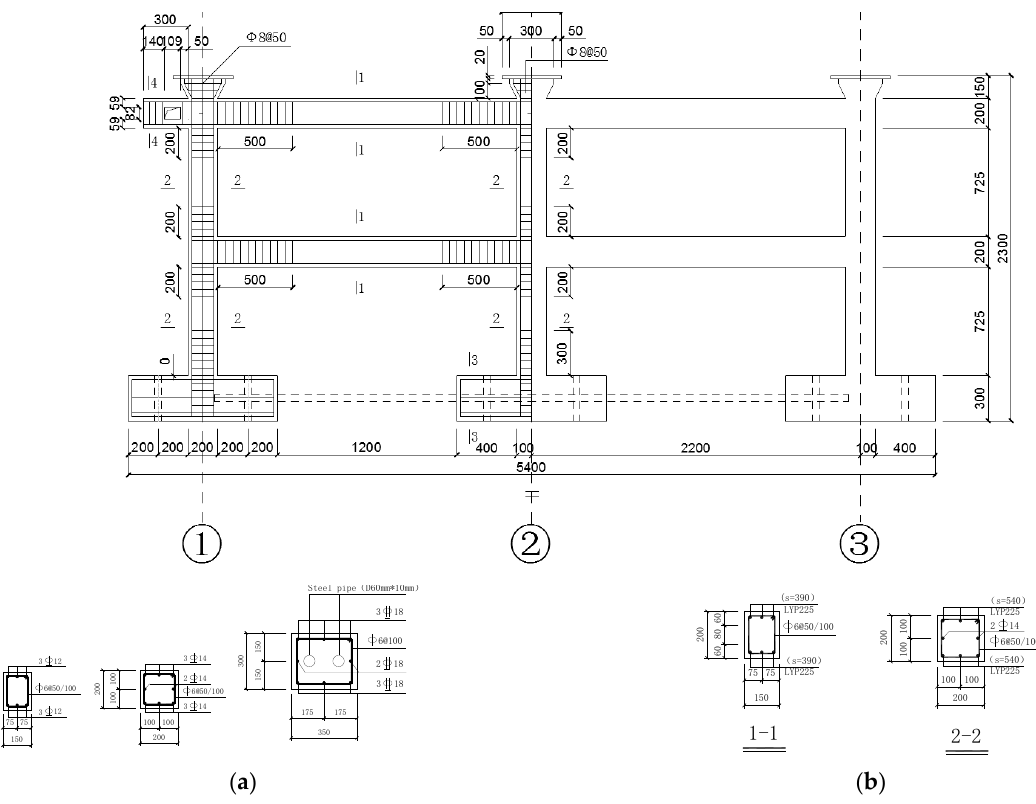
Figure 1. Dimension and steel details of frame specimens (Unit: mm). ( a ) KJ-1. ( b ) KJ-2.